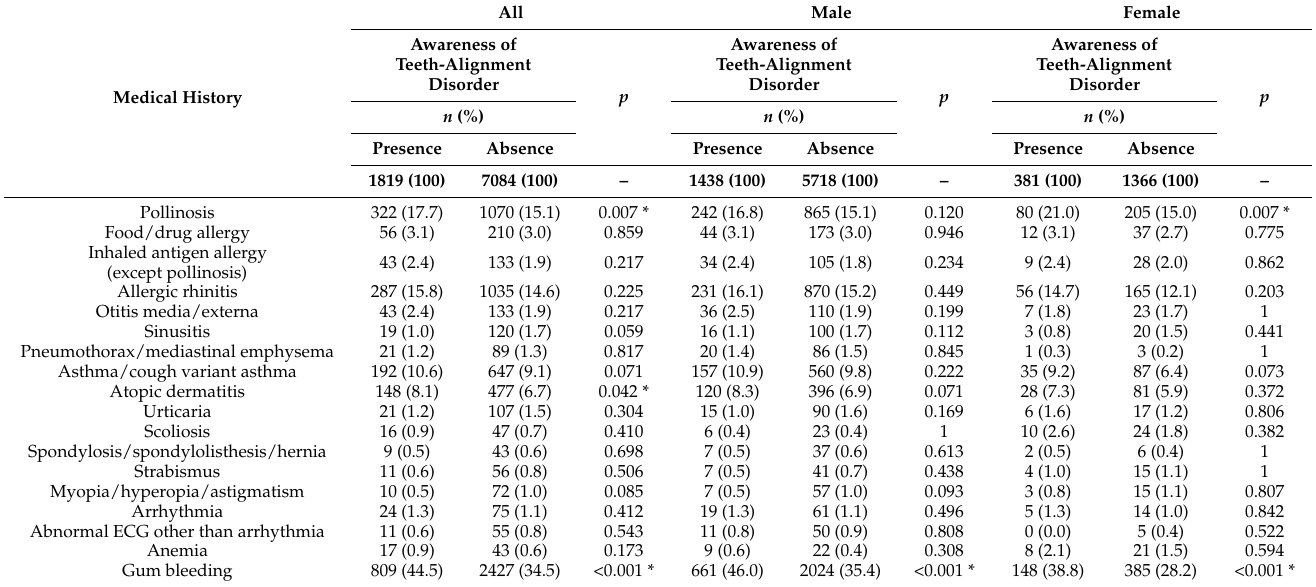
Table 2. The association between awareness of teeth-alignment disorder and medical